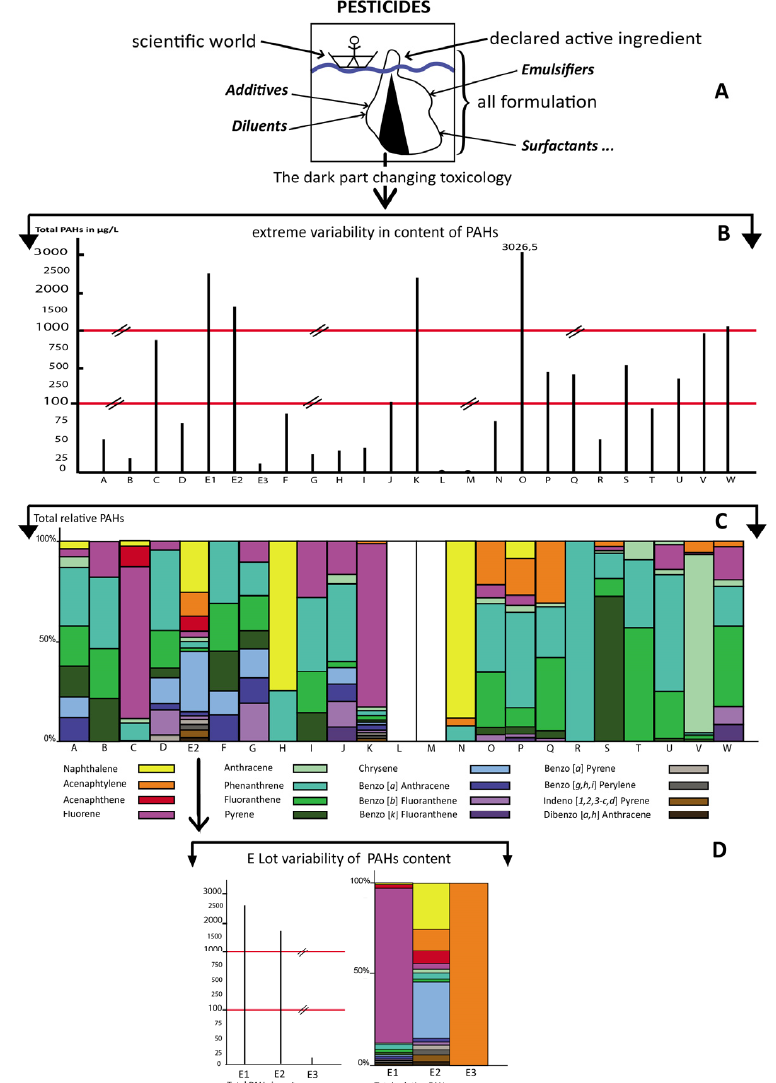
Figure 1. The hidden part of pesticide toxicology altered by formulants and contaminants. At the top ( A ), a symbolic iceberg shows the major role of formulants (additives, diluents, emulsifiers, surfactants, etc.) in pesticide toxicology. The extreme variability in content of PAHs (crude levels) is not taken into account, including percentage of the total formulation ( B ), since only the declared active ingredient is considered. The levels of PAHs in different lots of the same product appear variable and are not declared but studied in that work ( C ), including the variability for the same pesticide but different lots ( D ). L and M appear without any of the 16-priority PAHs measured; however, lighter monoaromatic hydrocarbons could be present ( C